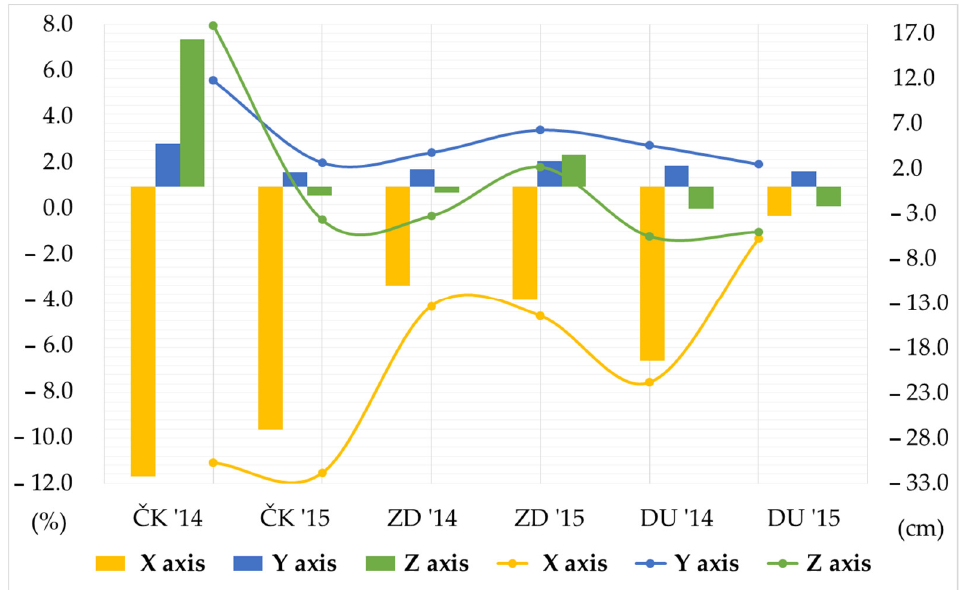
Figure 5. Movement of the RMSE deviation value using the proposed model from the exact geodetic position of the observed locations obtained using a GPS system and expressed in absolute (right y -axis) and relative (left y -axis) values.